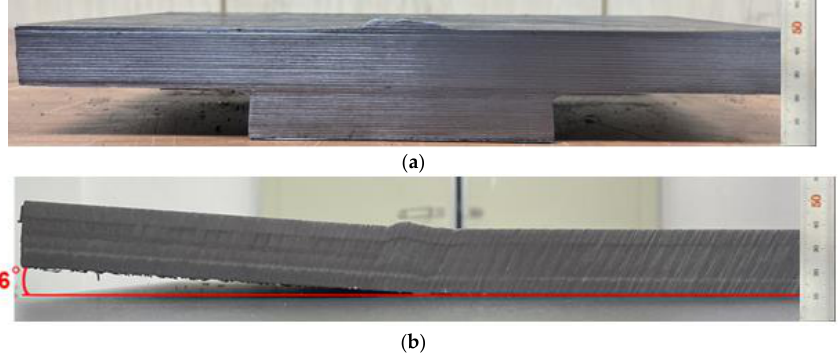
Figure 12. Angular distortion with constrained and unconstrained weld specimens. ( a ) Constrained weld specimen; ( b ) Unconstrained weld